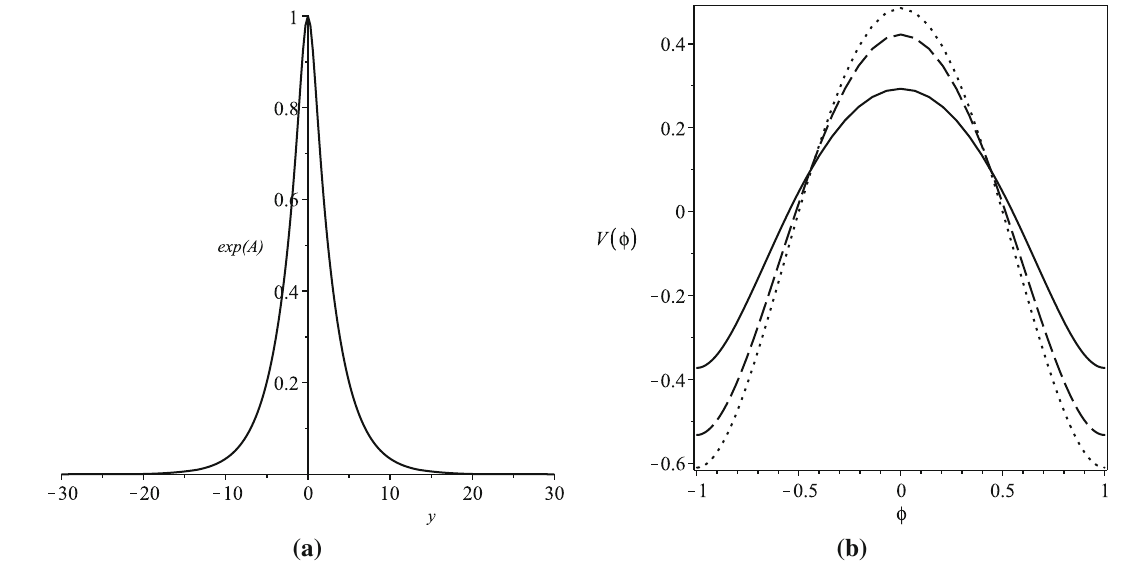
Fig. 2 The profile of a the warp factor e A ( y ) for a = 1, k = m = 1 and b the scalar field potential V (φ) for a = 1 (solid line), a =2 (dashed line), a = 5 (dotted